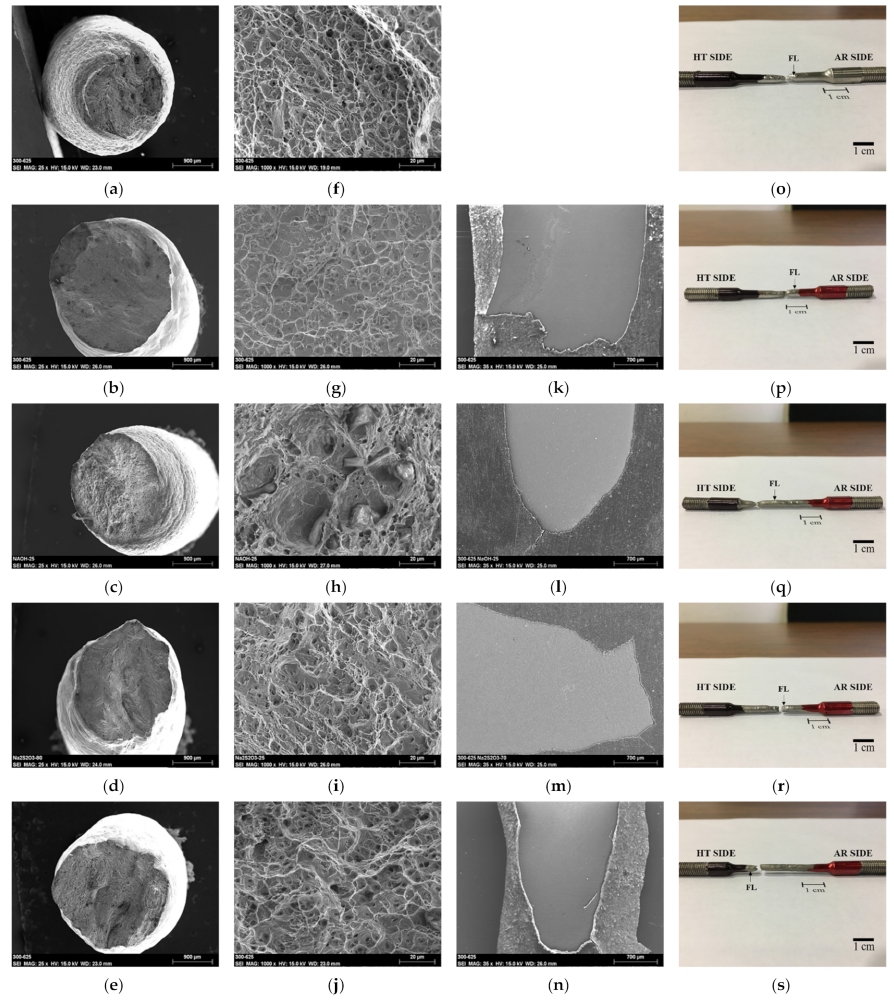
Figure 8. The SEM characterization of the fractured specimens for the ERNiCrMo-3 welded joint in the inert and corrosive environments. ( a , f , o ) air; ( b , g , k , p ) Na 2 S 2 O 3 at RT; ( c , h , l , q ) NaOH at RT; ( d , i , m , r ) Na 2 S 2 O 3 at 80 ◦ C, and ( e , j , n , s ) NaOH at 80 ◦